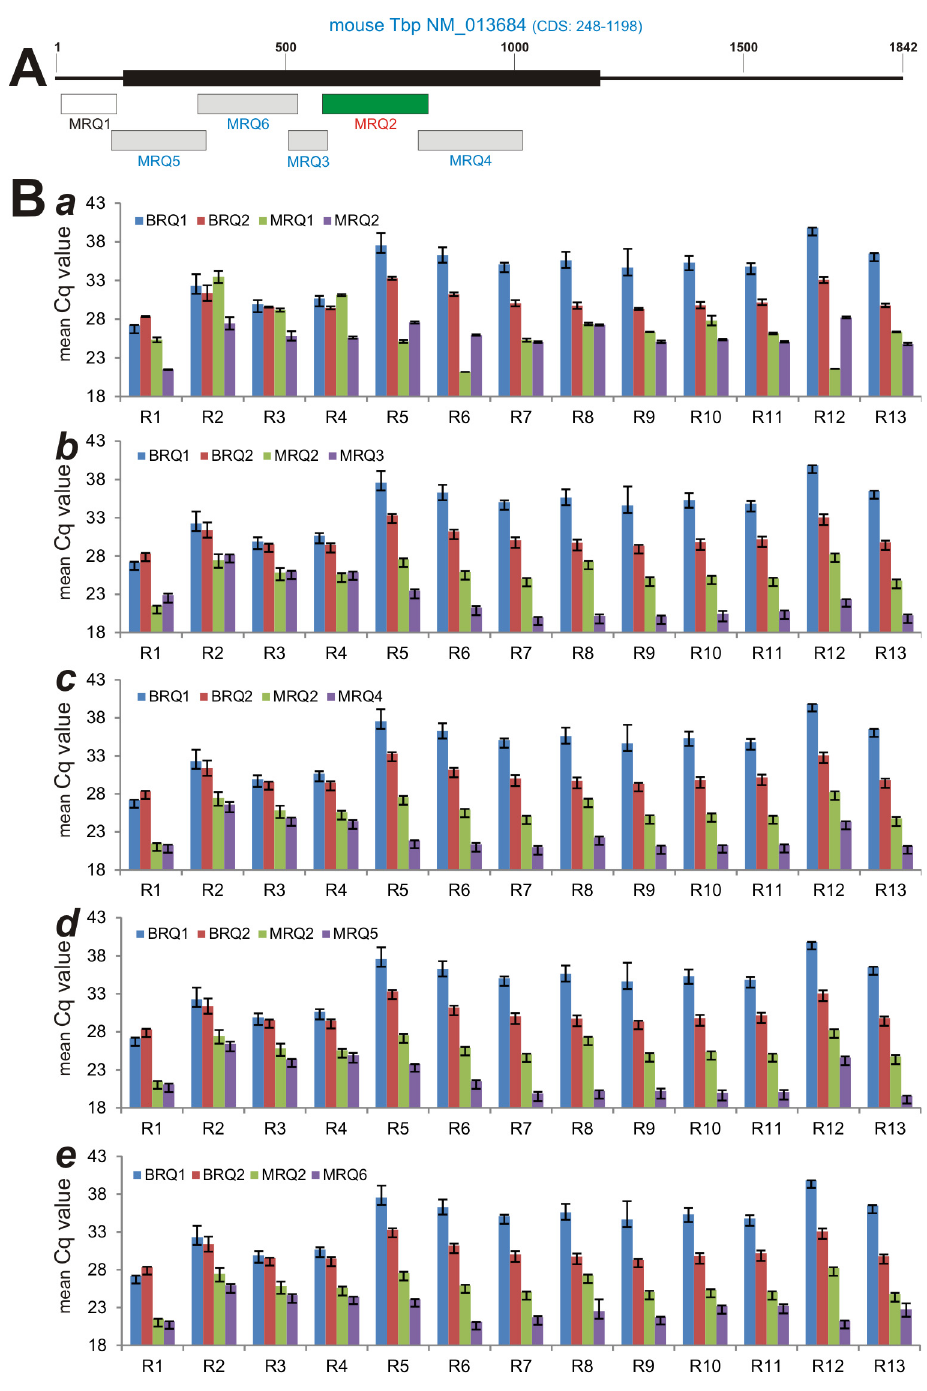
Fig 6. Evaluation of customized TqPCR primers that can be used to assess the RT-reverse transcription quality (RQ) of qPCR templates from mouse RNA samples. (A) Schematic representation of the sizes and locations of the PCR primers (also see S2 Table). (B) Comparison and correlation analyses of mean Cq value differences between Bio-Rad ’ s RQ1 and RQ2 primers (BRQ1 and BRQ2) and customized RQ primers (e.g., MRQ1 through MRQ6). The mean Cq values were obtained by performing TqPCR assay. Possible correlations between BRQ1/2 and MRQ primers were further analyzed